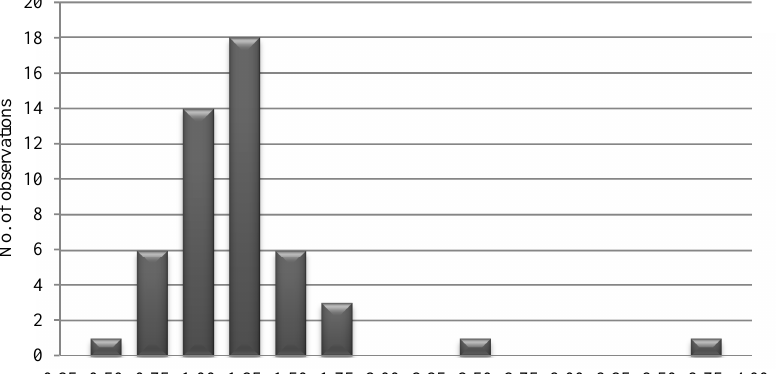
Figure 1. Distribution of growth rates for the indicator “Value of shipped products” 2013/2012 by Pearson's χ